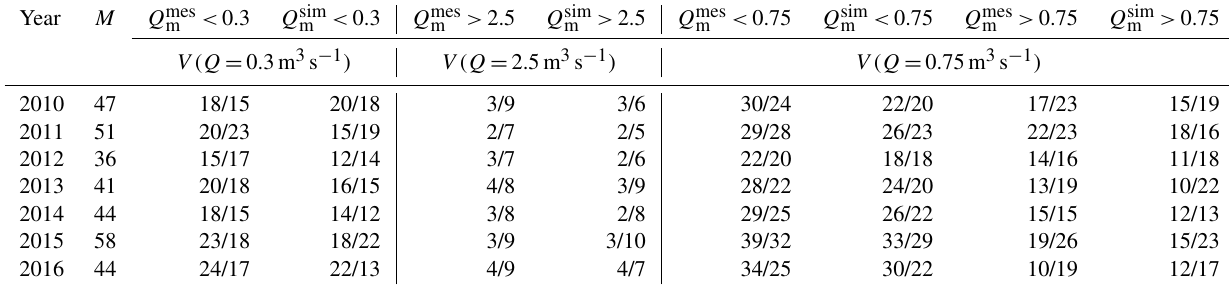
Table 4. Comparison of measurement and calculated results in the analyzed